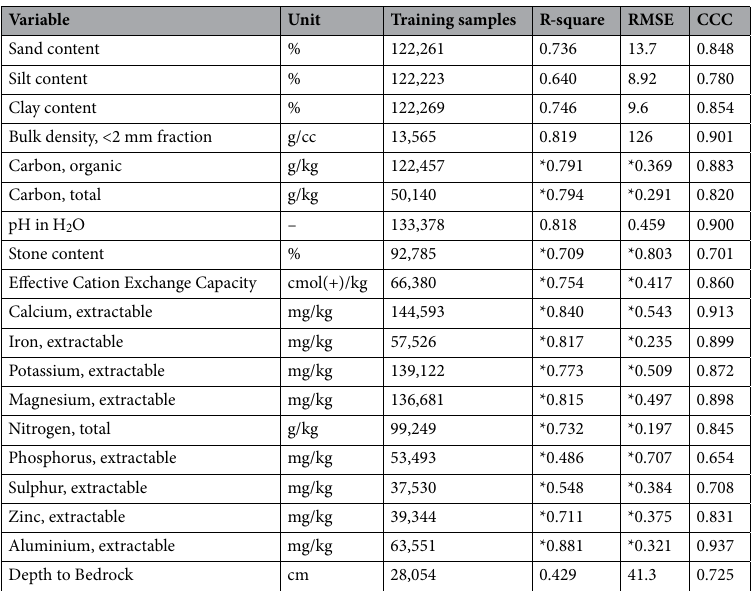
Table 1. List of variables provided via iSDAsoil and average accuracy performance based on the fivefold spatial cross-validation (R-square, RMSE and Concordance Correlation Coefficient). Extractable elements are based on Mehlich-3 method. *Statistics based on the ln-transformed values. See also Supplementary material for detailed summary statistics per